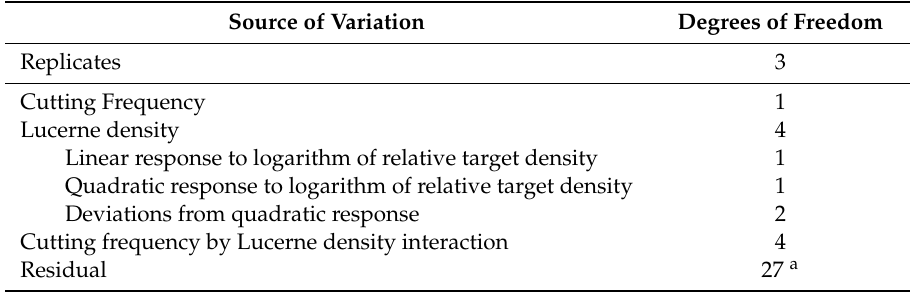
Table 1. Structure of analysis of variance for the square root of the number of crowns at each sampling occasion in Experiment 1 (Burraja). Source of Variation Degrees of Freedom Replicates 3 Cutting Frequency 1 Lucerne density 4 Linear response to logarithm of relative target density 1 Quadratic response to logarithm of relative target density 1 Deviations from quadratic response 2 Cutting frequency by Lucerne density interaction 4 Residual 27 a a 25 degrees of freedom for the November 2000